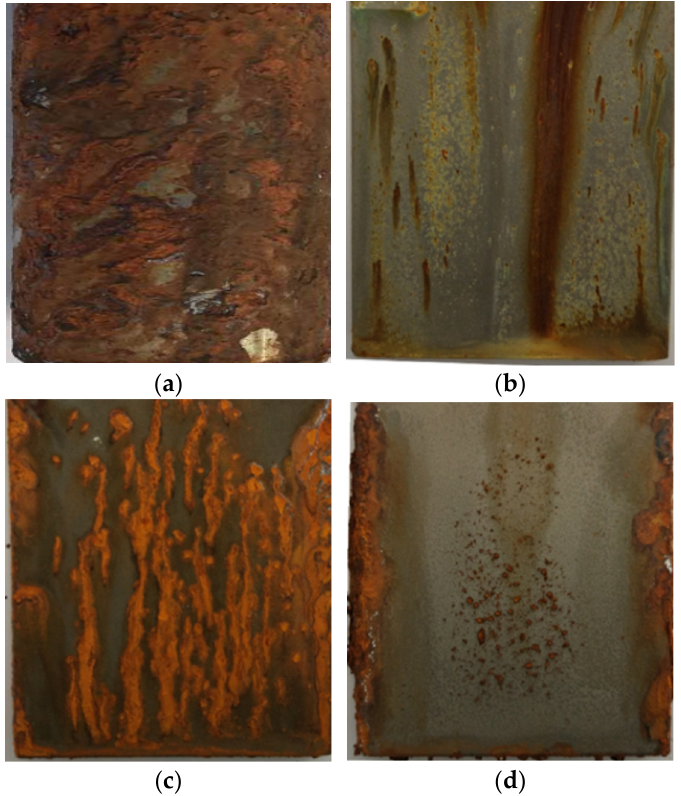
Figure 8. Corrosion morphology of HVOF coatings and hard chrome plating by salt spray test. ( a ) hard chrome plating, ( b ) Ni60 coating, ( c ) WC10Co4Cr coating, ( d ) 316L coating.